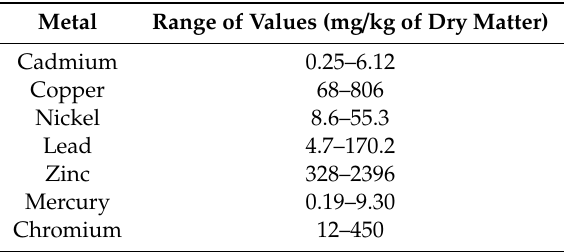
Table 5. Concentration of heavy metal in the tested